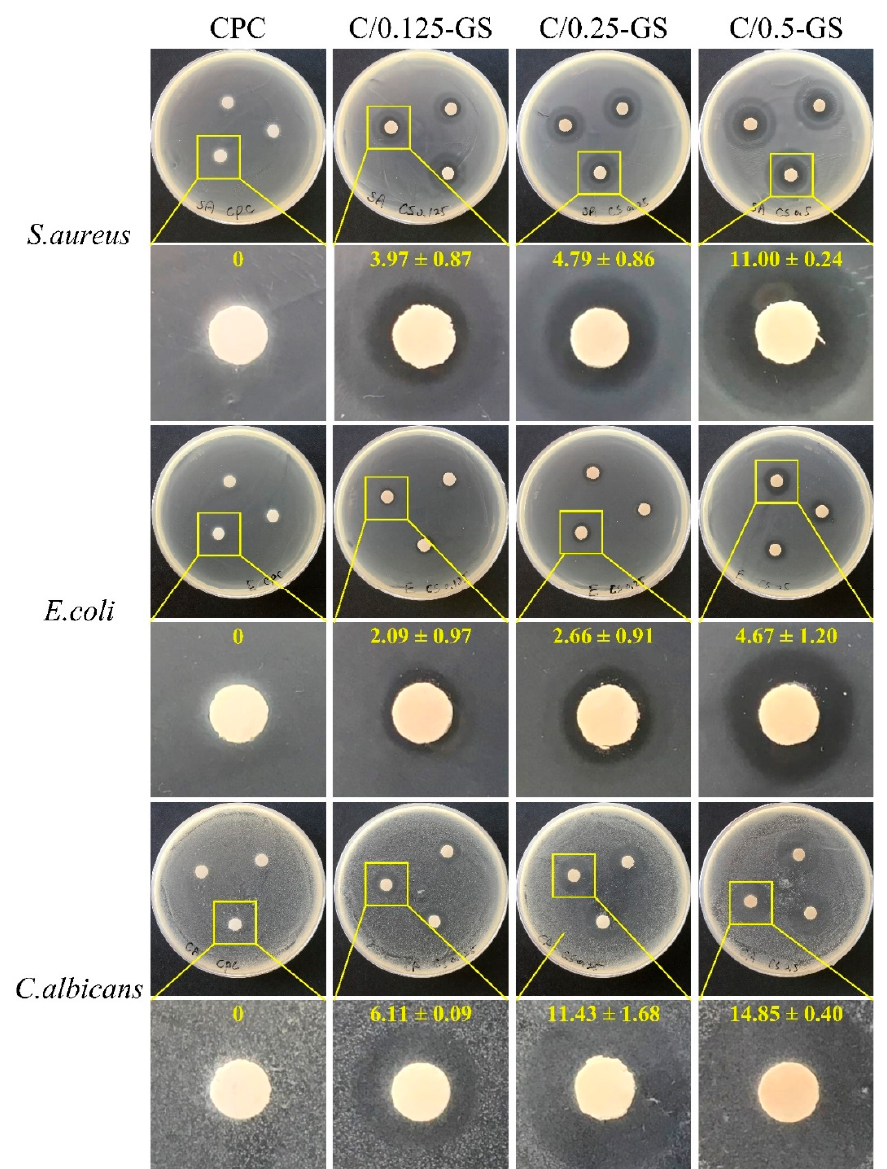
Figure 7. Analysis of three different bacterial inhibitory zones of CPC/hydrogels with gentamicin after 1 day of incubation (value unit: mm).